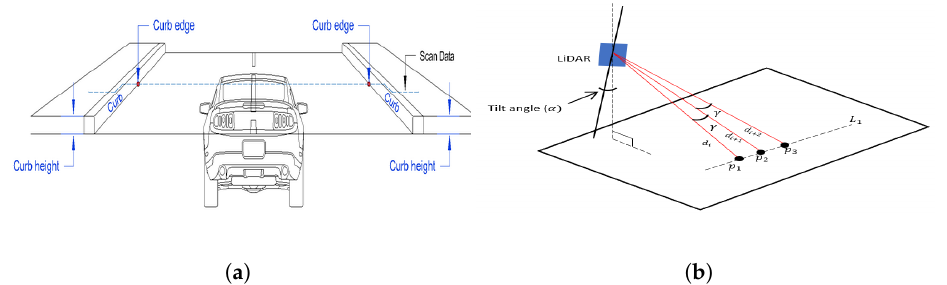
Figure 15. Line segment analysis proposed in [3] for road curb detection. ( a ) Line segment analysis. ( b ) Laser data points on road